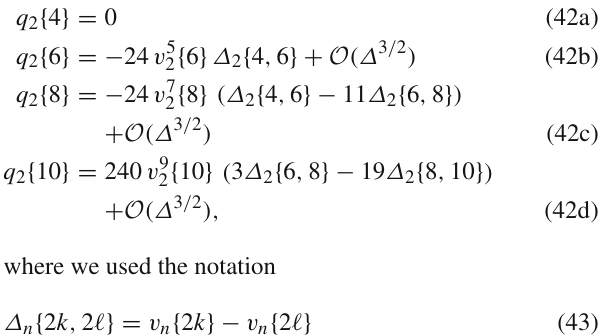
Fig. 4 Using iEBE-VISHNU output, the true value of ¯ v 2 is compared with the estimators ¯ v 2 { 2 k }